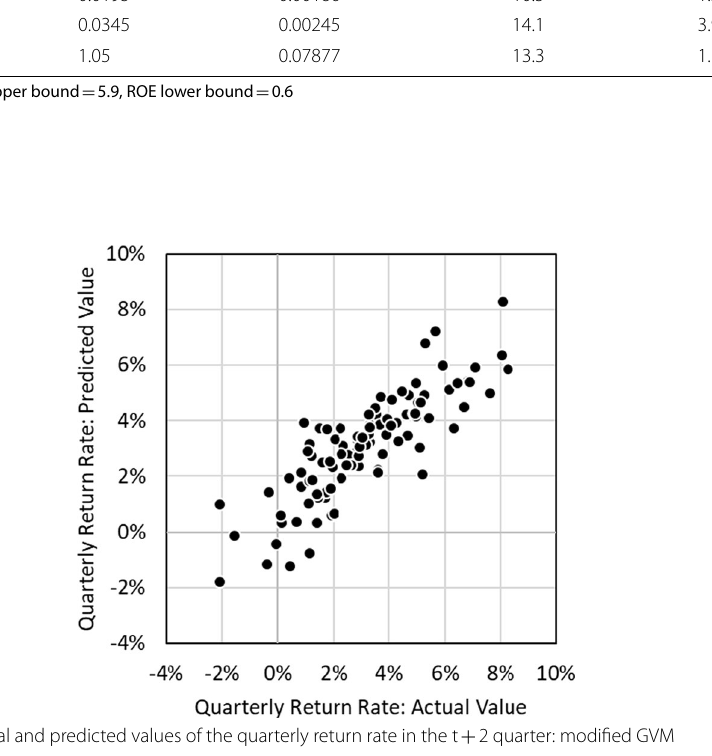
Table 2 The expected rates of return model: modified GVM